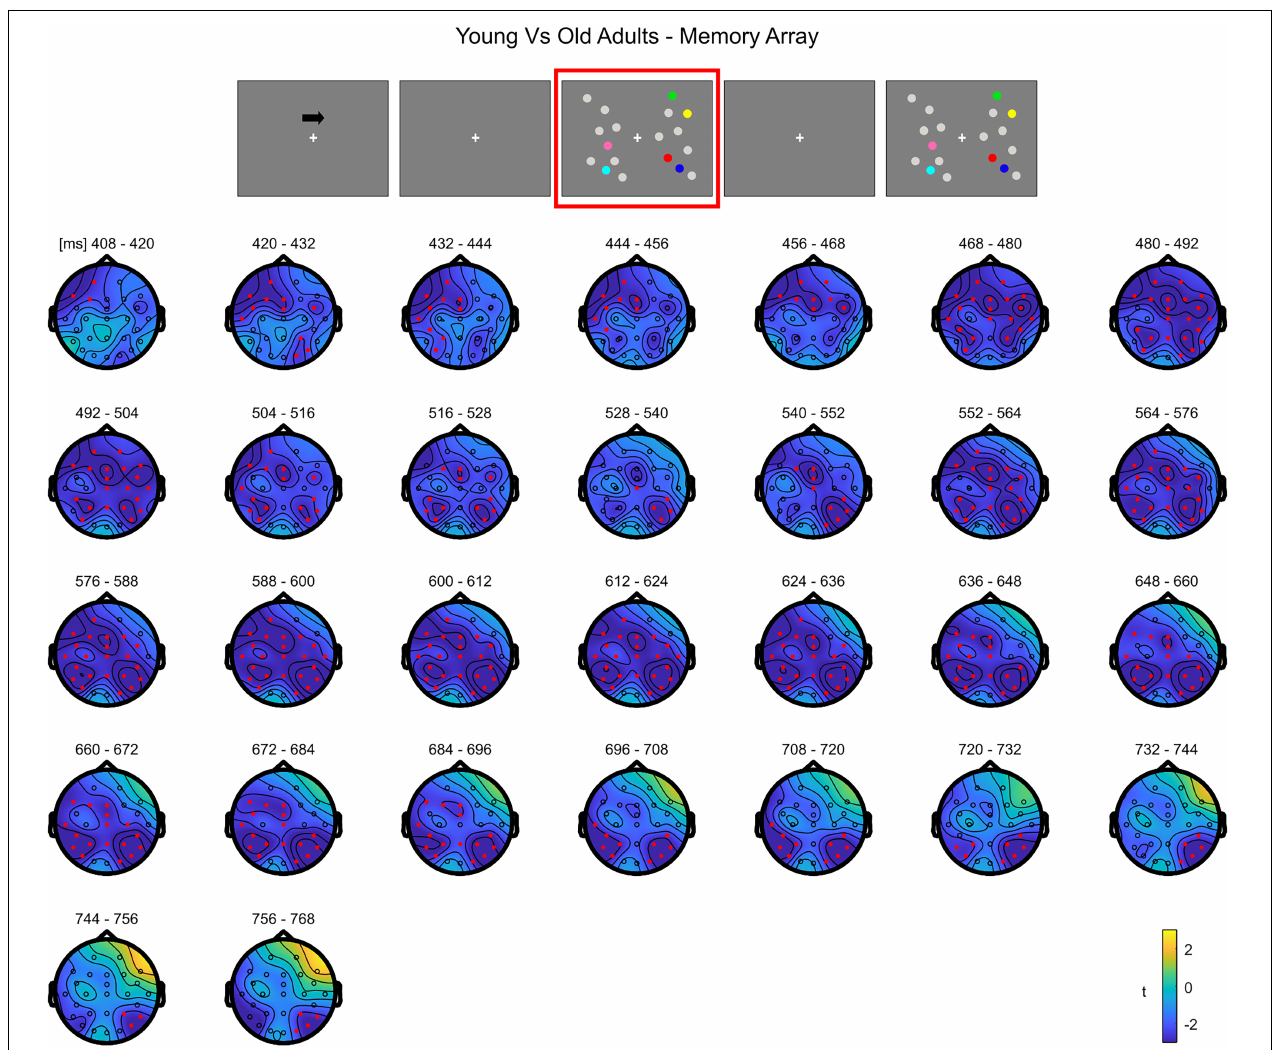
FIGURE 4 | Cluster-based permutation independent-samples t -test results on the load effect between the two groups during memory retention. The spatio-temporal evolution of the significant Group effect is represented through topographical maps of the clusters averaged in bins of 12 ms. Only significant time windows are depicted (for the complete time course, see Supplementary Figure 3 ). Red dots represent the significant effect. The color bar represents the range of t -values. Left and right channels are set as contralateral and ipsilateral to targets,